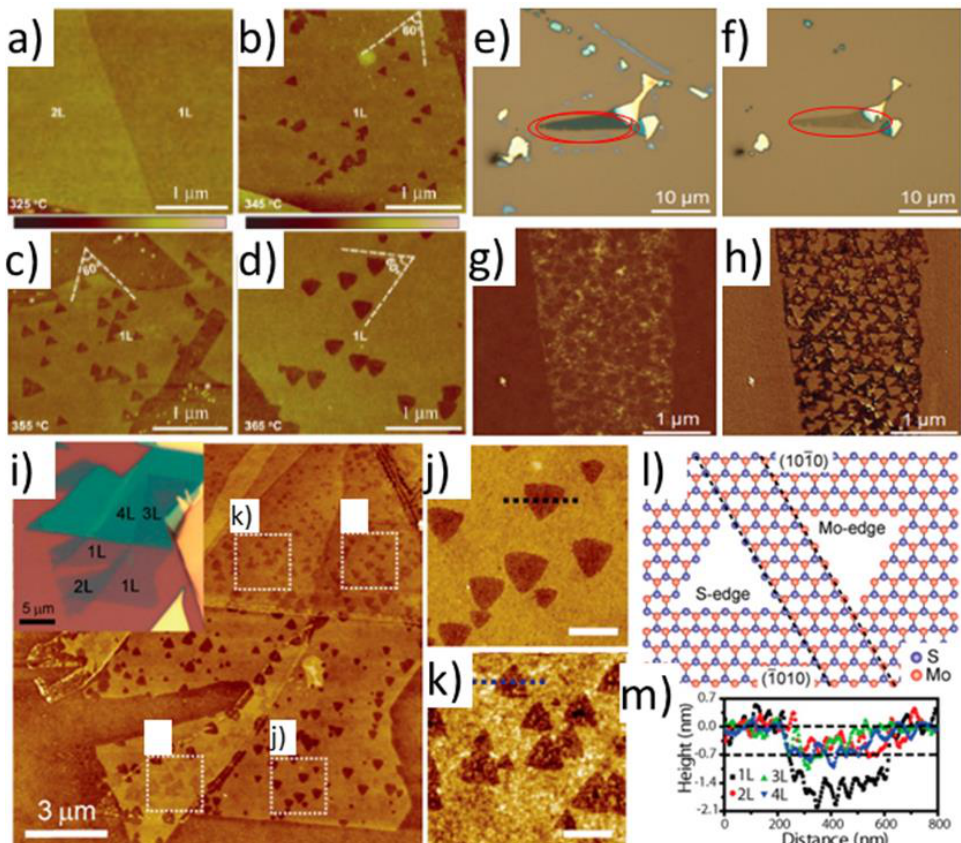
Figure 5. Three seminal studies from 2013 detailing oxidative thermal etching onto basal planes of thin 2H MoS 2 crystals with emphasis on the formed triangular etch pits. ( a – d ) Typical AFM height images showing growth of the equilateral triangular etch pits on a single MoS 2 flake at sample temperatures of 325, 345, 355 and 365 °C, respectively (each heated for 2 h) [33]. ( e – h ) Simultaneous etching and thinning of 2L MoS 2 nanosheet [34]. ( e – f ) Optical image of the flake before ( e ) and after ( f ) thermal annealing at 330 °C for 15 h. AFM height ( g ) and phase ( h ) images of the thinned MoS 2 nanosheet. ( i ) AFM topography image of a thin MoS 2 flake annealed at 320 °C for 3 h [35], ( j , k ) close-ups on two areas surrounded by dashed lines in the panel ( i ) and differing in the number of MoS 2 monolayers: 1 L in ( j ) and 4 L in ( k ). They show alternating triangular etch pits between odd and even number of layers. ( l ) Schematic molecular structures of the suggested etch pits. The structure with Mo-edges exposed was suggested to be more stable. ( m ) Height profiles along the dashed lines passing through selected pits confirming their preferential depth of 1 MoS 2 layer. Parts ( a – d ) are reprinted from Reference [33], with permission from Springer Nature Customer Service Centre GmbH: Springer Nature, Nano Research (2013); parts ( e – h ) are reprinted from Reference [34], with permission. Copyright ©2013 WILEY-VCH Verlag GmbH & Co. KGaA Weinheim. Parts ( i – m ) are reprinted in part from Reference [35], with permission. Copyright 2013 American Chemical Society.